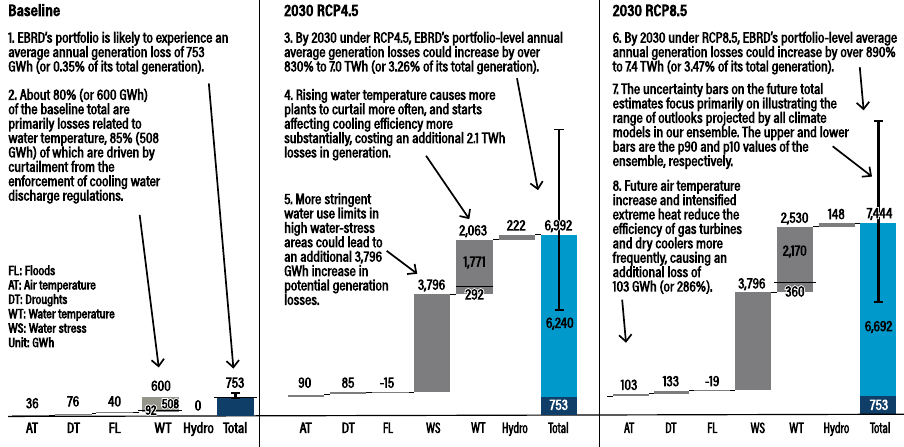
Fig. 4 EBRD ’ s estimated portfolio-level physical climate risk-induced generation losses for the baseline period and by 2030 under RCP4.5 and RCP8.5. Generation loss estimates reported in the text in the fi gure are ensemble medians. The vertical line on each total bar indicates the climate model- induced uncertainties, i.e., the lower bound is the 10th percentile (p10), and the upper bound is the 90th percentile (p90). For thermal plants, the physical climate risks are categorized according to the climatic variables, i.e., air temperature (AT), droughts (DT), fl oods (FL), water stress (WS), and water temperature (WT). Water temperature bars are divided into two parts with a black horizontal line. The lower part represents the cooling ef fi ciency reduction-caused generation losses, and the upper is generation losses driven by curtailment from cooling water discharge regulation enforcement. There are 80 power